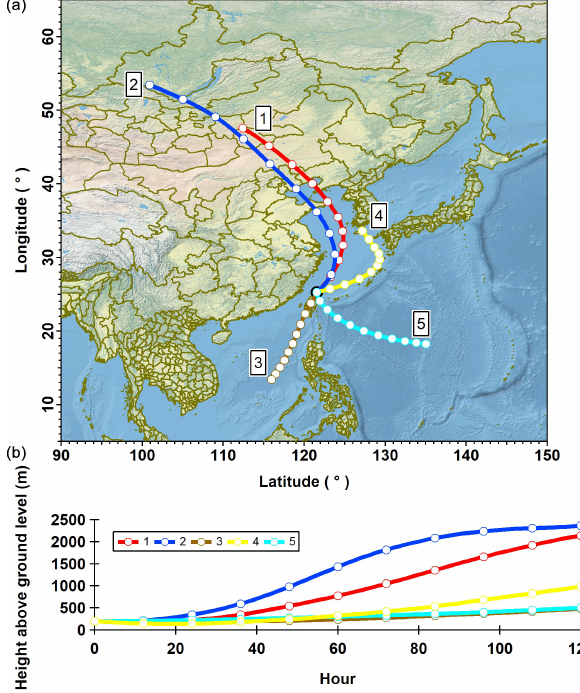
Figure 3. Cluster classification of 120h back trajectories during measurement period (upper panel), and air mass heights are shown in the graph below. Air masses with both clusters 1 and 2 origi- nated in the inland regions of the Asian continent, but the move- ment of cluster 2 air masses was faster and from a higher elevation. Air masses in cluster 4 were pushed by a high-pressure system to- wards the south of the Korean Peninsula and Japan and then moved along the marine boundary slowly before reaching the CAFÉ sta- tion, while clusters 3 and 5 represent air masses that originated in the South China Sea and remote Pacific region, respectively. The data for the back-trajectory plot overlaid on the map are obtained from the HYSPLIT model of NOAA. The digital map (in panel a ) is generated using Igor Pro 6.37 (©